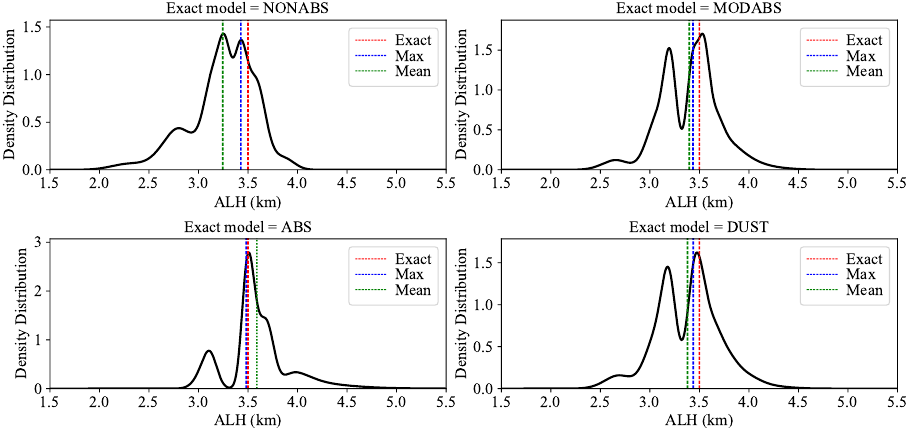
Figure 6. The mean a posteriori densities p mean ( h | y δ ) for m e = NONABS, MODABS, ABS, DUST, τ e = 0.5, and h e = 3.5 km. In each plot, the red vertical dashed line correspond to the exact values to be retrieved ( τ e , h e ), the blue vertical dashed line to the maximum solution estimate ( τ max , h max ) , and the green dashed line to the mean solution estimates ( τ mean , h mean